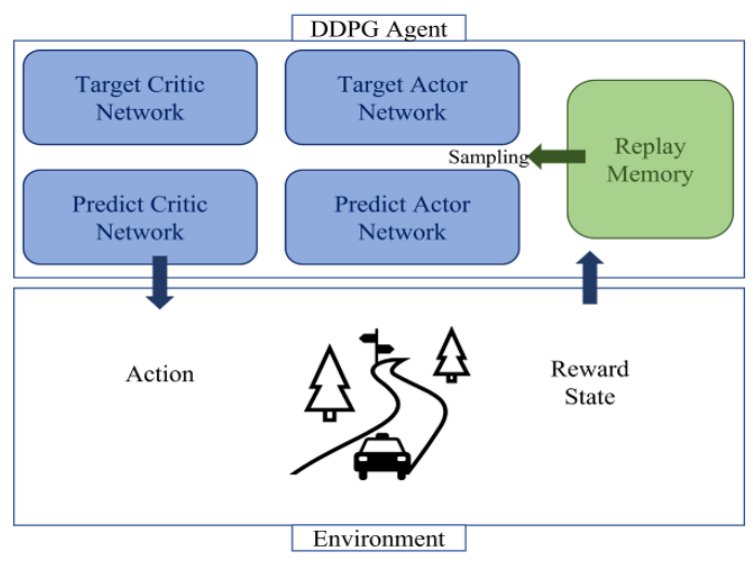
Figure 3. Architecture of DDPG.